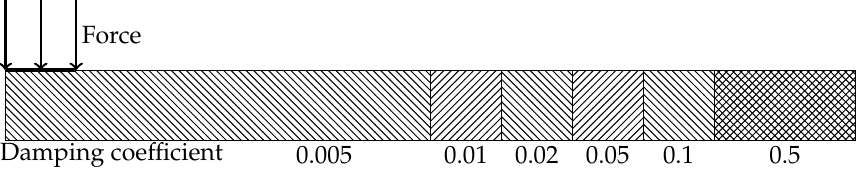
Figure 13. 2D FEM model for the simulation of wave propagation in an endless